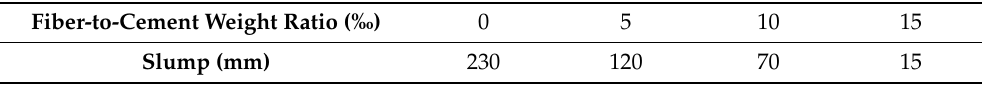
Table 5. Slump values of the benchmark concrete and the KFRC specimens under various weight